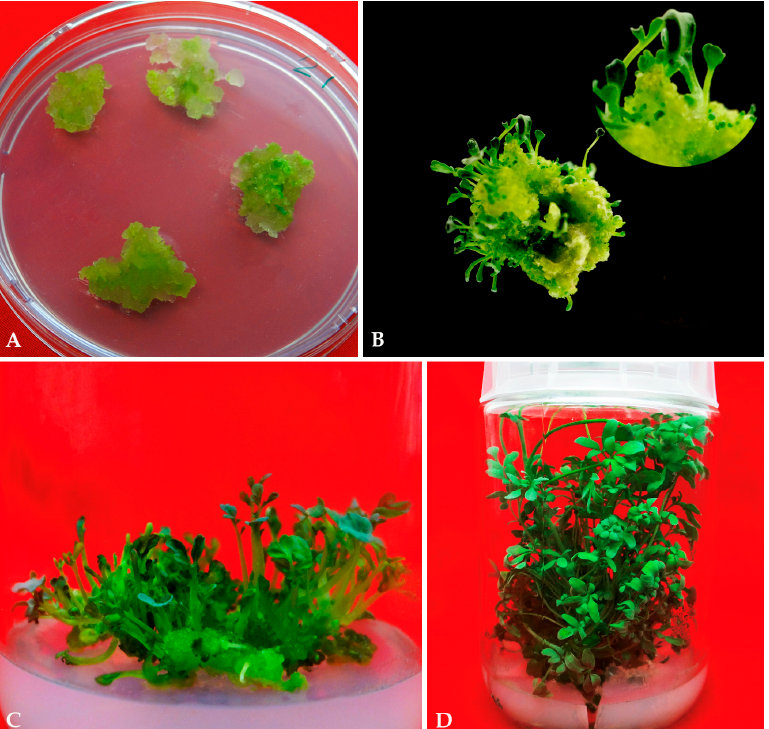
Figure 1. Callus induction and shoot bud induction and multiplication of R. chalepensis . ( A ). Callus induction in internodal explants on MS with 2,4-D (10.0 μ M) + BA (1.0 μ M) ( B ). Shoot bud